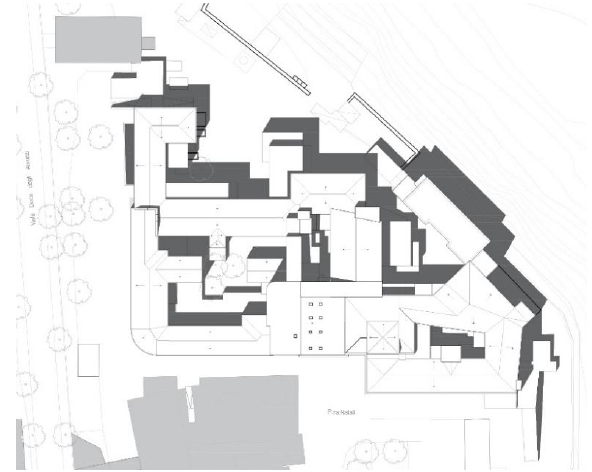
Figure 2. Planivolumetric map of the former hospital, San Salvatore.